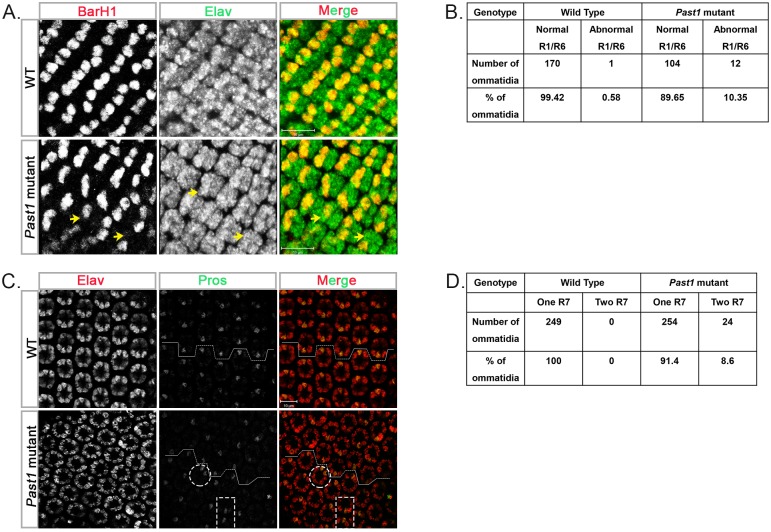
Specification of R1/R6 and R7 photoreceptors in Past1 mutant eyes.(A) BarH1 (grey, or red in the merge) and Elav (grey, or green in the merge) staining of wild type and Past1110-1 homozygous mutant eye discs from third instar larvae. Shown are Z-projections of confocal sections. The yellow arrow marks the missing photoreceptors. (B) Elav (grey, or red in the merge) and pros (grey, or green in the merge) staining of wild type and Past1110-1mutant early-mid pupa eyes (42-48h after puparium formation). The dotted line marks the equator of the eye, defining the dorsal and ventral parts of the eye. The dotted circle delineates an ommatidium with two R7 photoreceptors and the dotted rectangle outlines two neighboring ommatidia that face each other in the same dorsal part of the eye. (C) Quantification of ommatidia containing one or two R7 photoreceptor in wild type (n = 249) and Past1110-1mutant (n = 278) ommatidia; P < 0.001.